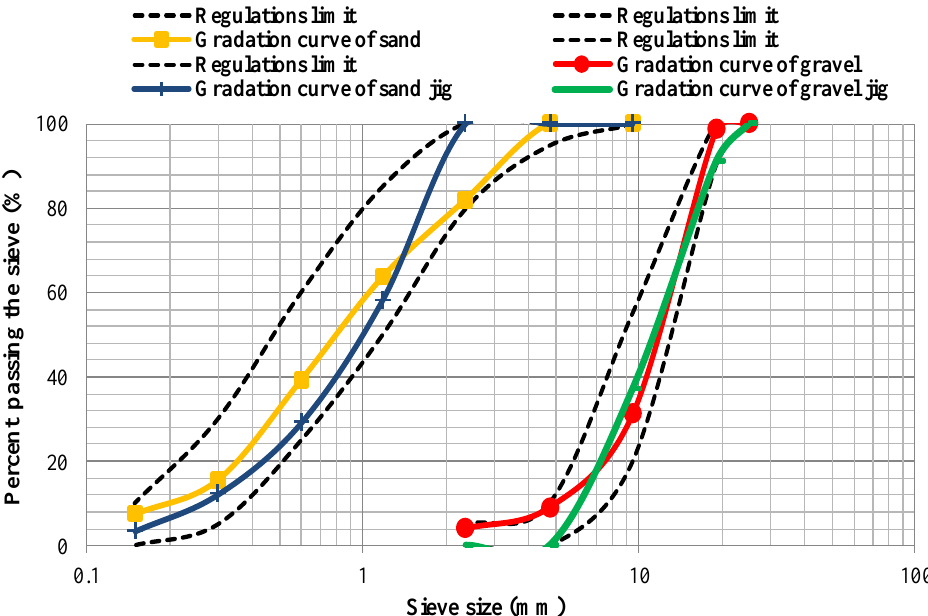
Figure 1. Gradation curves of natural and coal waste aggregates .